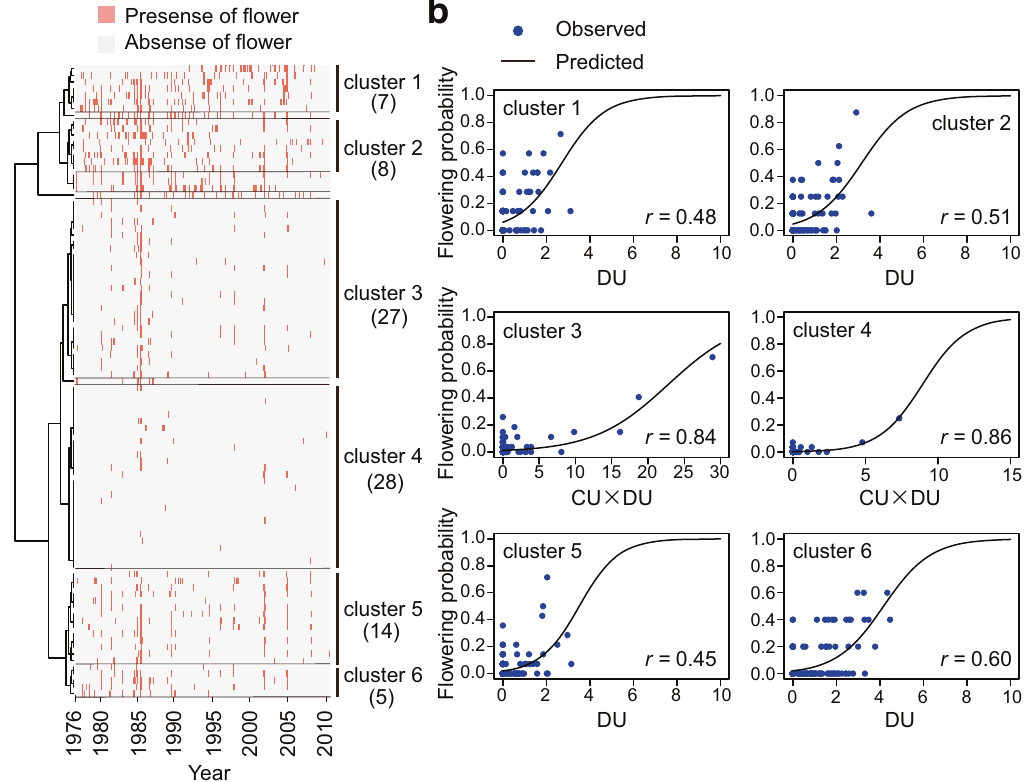
Fig. 4 Clustering of phenological patterns and fl owering phenology prediction for each phenological cluster. a Time-series clustering of 95 dipterocarp species based on the similarity of their fl owering (pink) and non fl owering (gray) patterns. The optimal number of clusters ( ^ m = 10) was identi fi ed by the minimization of AIC. Among the 10 clusters, clusters with fewer than fi ve species were excluded for phenology forecasting because of their small sample sizes. Thus, six clusters were used for phenology forecasting. The numbers in brackets indicate the number of species included in each cluster. b Comparisons between the predicted (black) and observed (blue) fl owering phenology of each phenological cluster during May 1976 to March 1996. To explain fl owering phenology, the CU × DU model was applied for clusters 3 and 4, whereas the DU model was selected for the other clusters. Pearson ’ s correlation coef fi cient ( r ) is given for each plot. Details for the model fi tting results are given in Supplementary Data